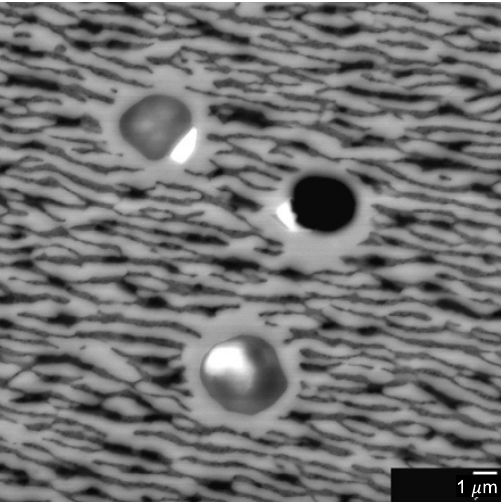
Figure 15. Backscattered electron image showing TCP phase particles and porosity in crept HIPed